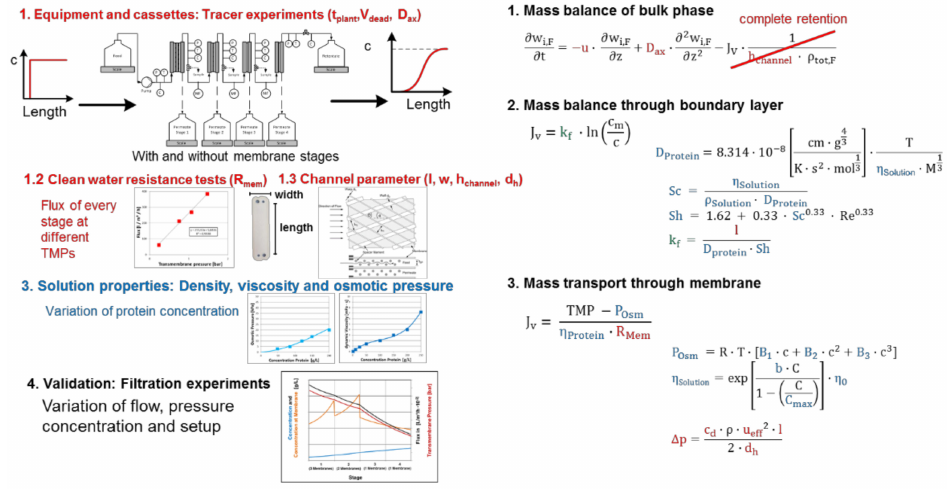
Figure 8. Single-pass tangential-filtration (SPTFF) process modeling workflow, recipe,